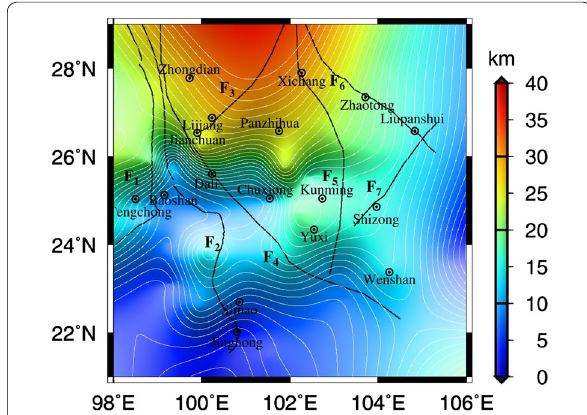
Fig. 8 Differences in the depths of the Curie surface and Moho surface. The positive value indicate that the depth of Curie surface less the depth of Moho surface